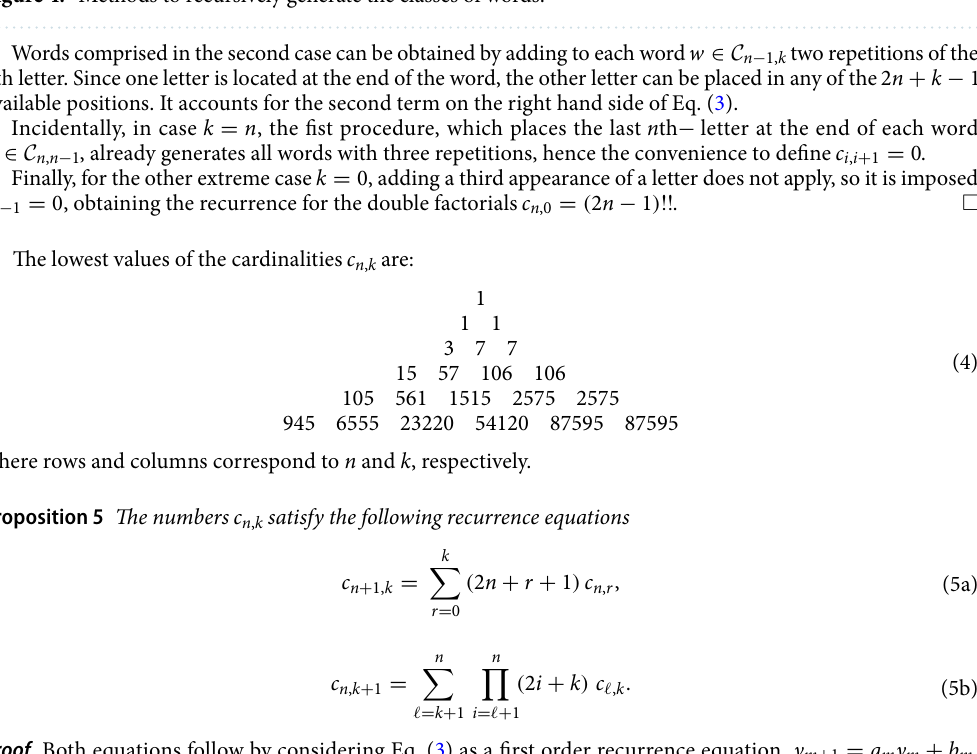
Figure 4. Methods to recursively generate the classes of